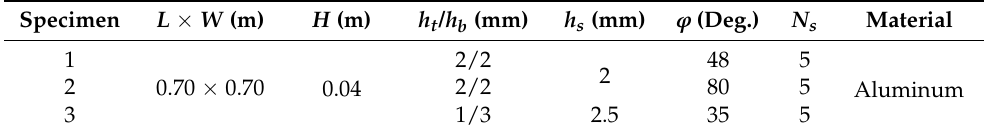
Table 7. Geometrical and physical parameters of the test specimens.